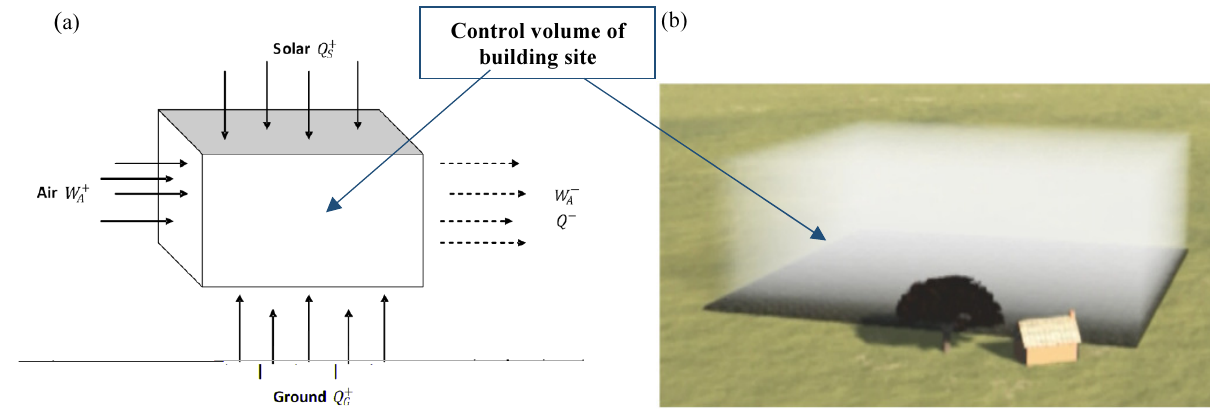
Fig. 3. Algorithm of theoretical RE potential assessment for building site